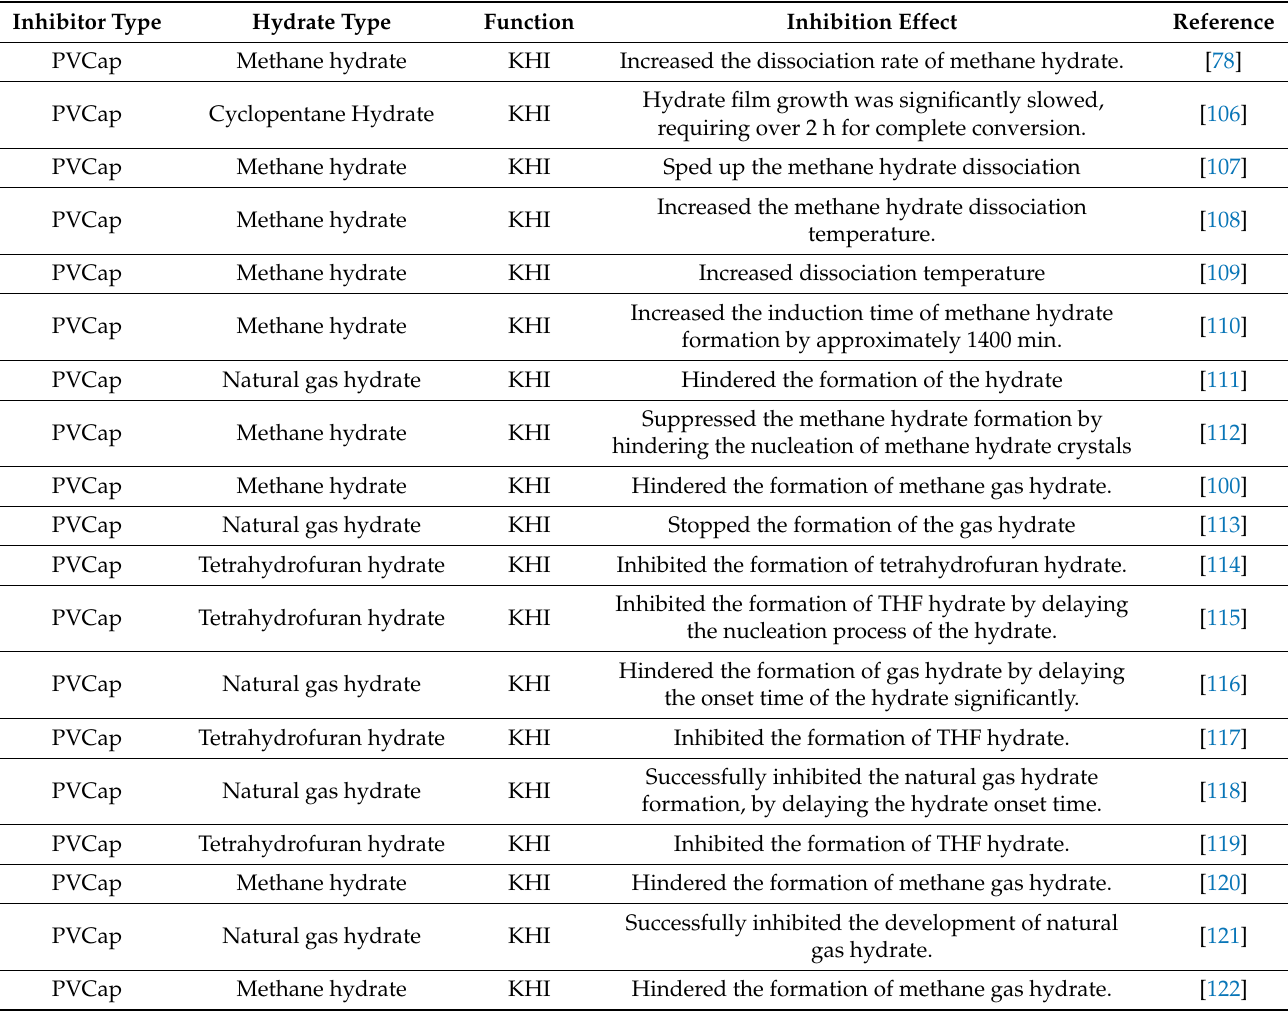
Table 5. Summary of PVCap hydrate inhibitors used in several